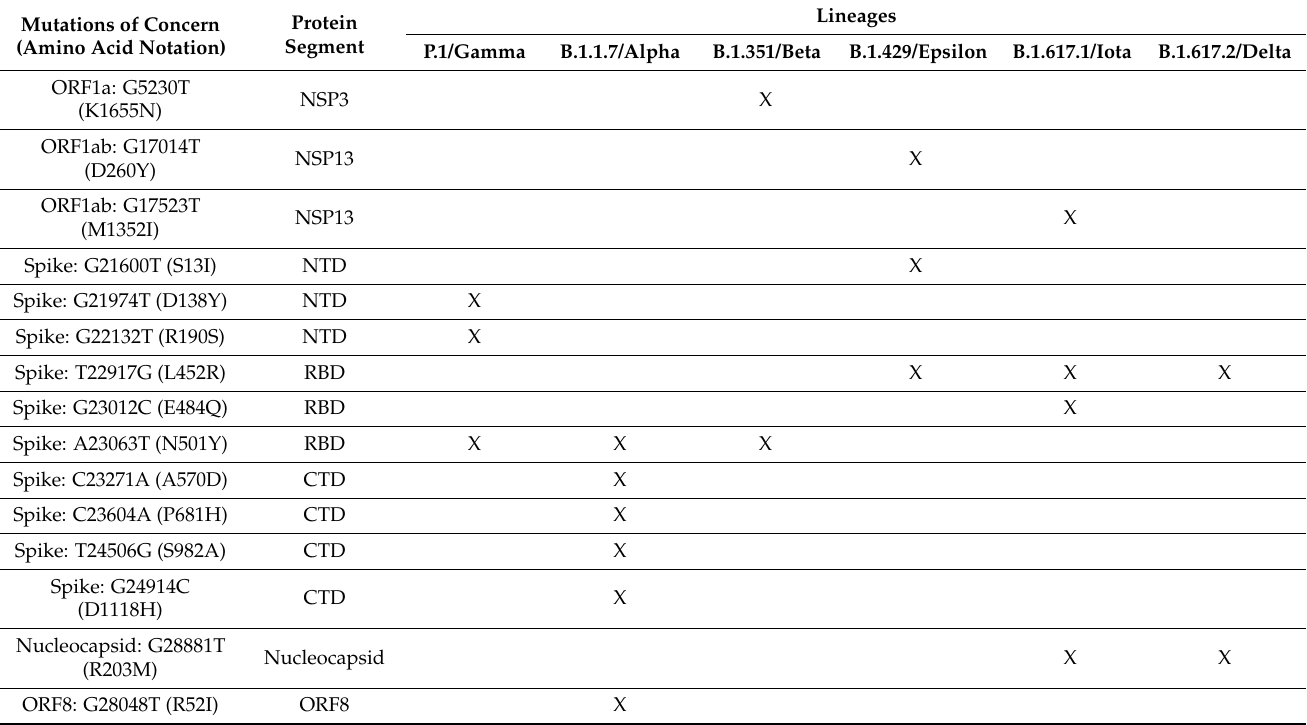
Table 3. n = 15 VoC/VoI mutations that appeared as candidate minor variants prior to becoming fixed variants were mostly associated with the spike protein including on the NTD and RBD protein domains. ‘X’ denotes which lineage(s) each mutation is predominantly found